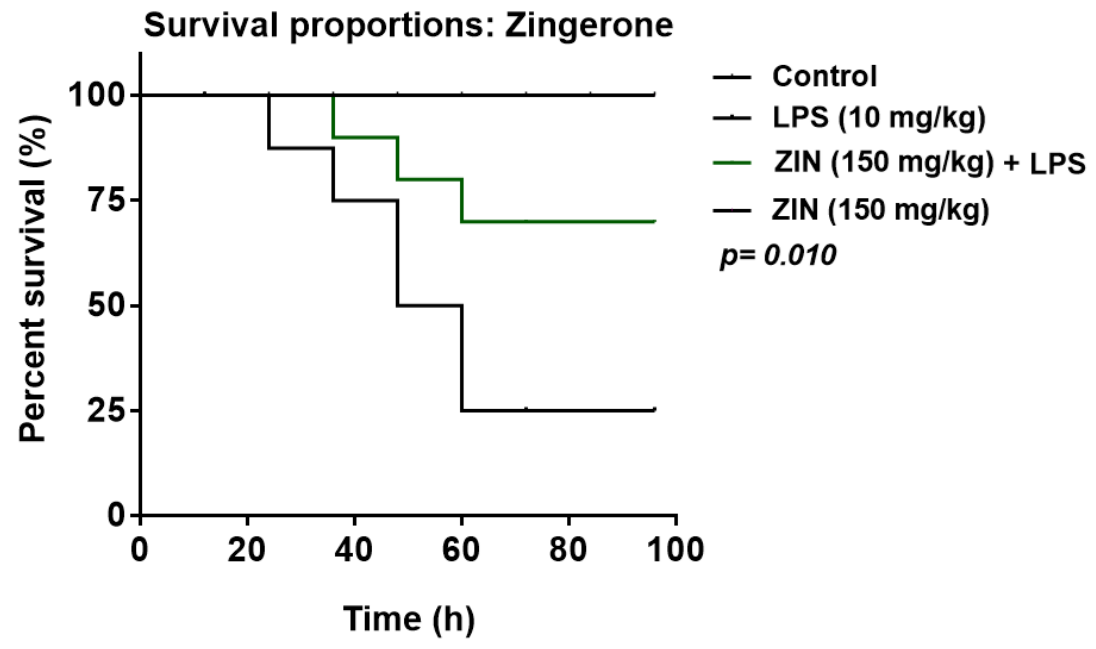
Figure 2. Kaplan–Meier survival plot (n = 10 rats per group). Effect of zingerone (ZIN) 150 mg/kg on survival rate of LPS induce systemic inflammation in rats.